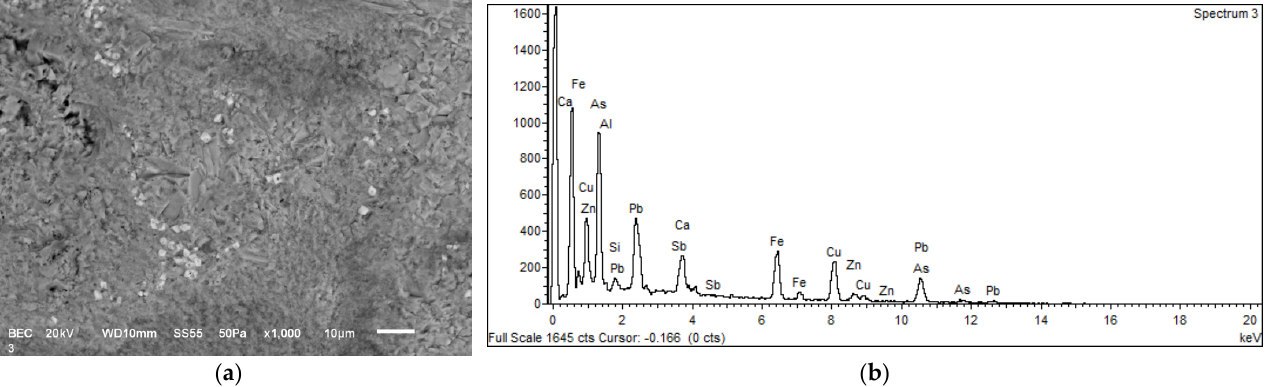
Figure 6. Sample 3. ( a ) backscattered electron image of the sample with minute Pb-Sb grains dispersed in the Cu-As matrix. ( b ) EDS spectrum of the grain.